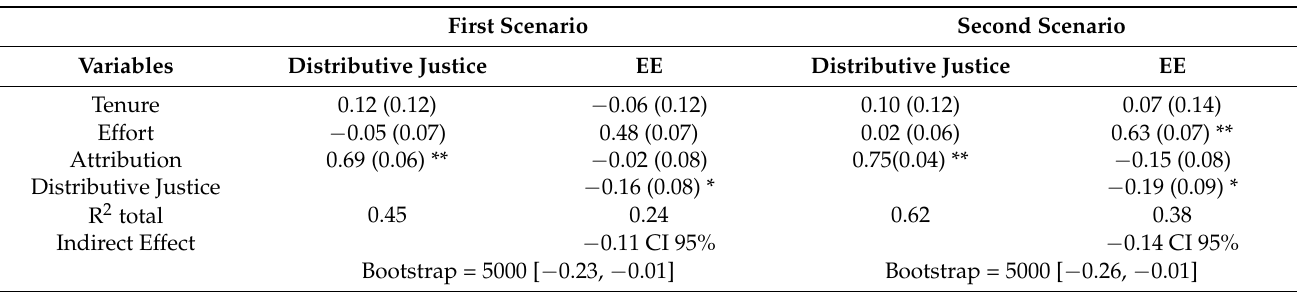
Table 3. SME model of distributive justice as a mediator between attributions of responsibility and expected emotional exhaustion (N =